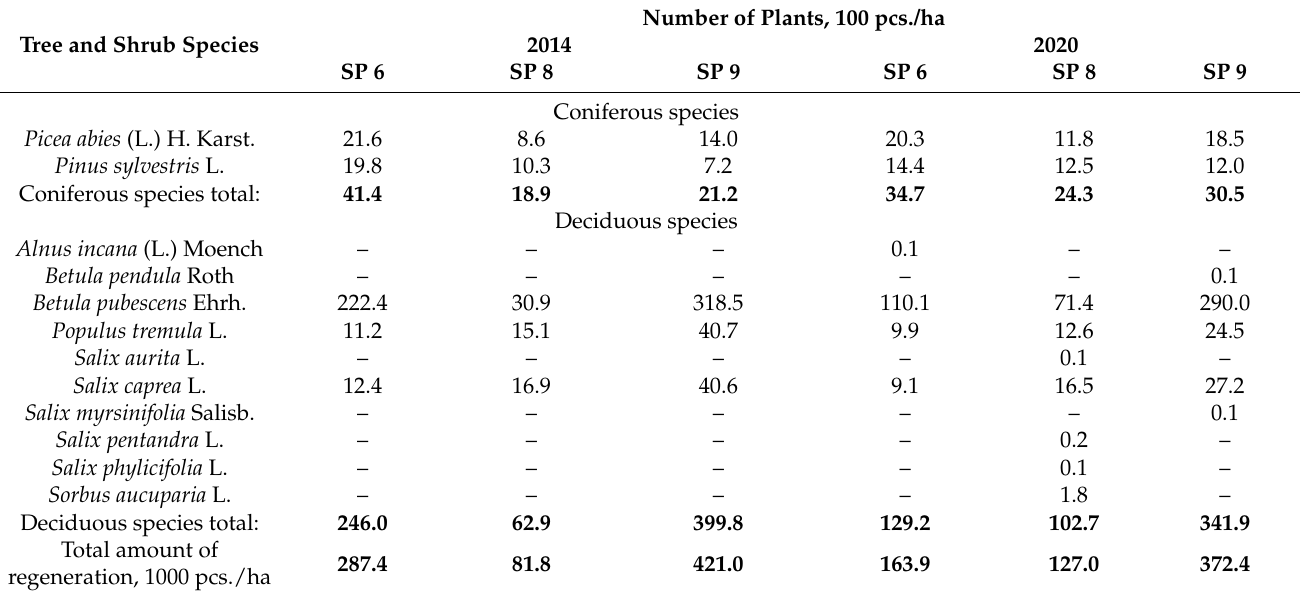
Table 1. Species composition and amounts of tree advance regeneration in burnt sites.